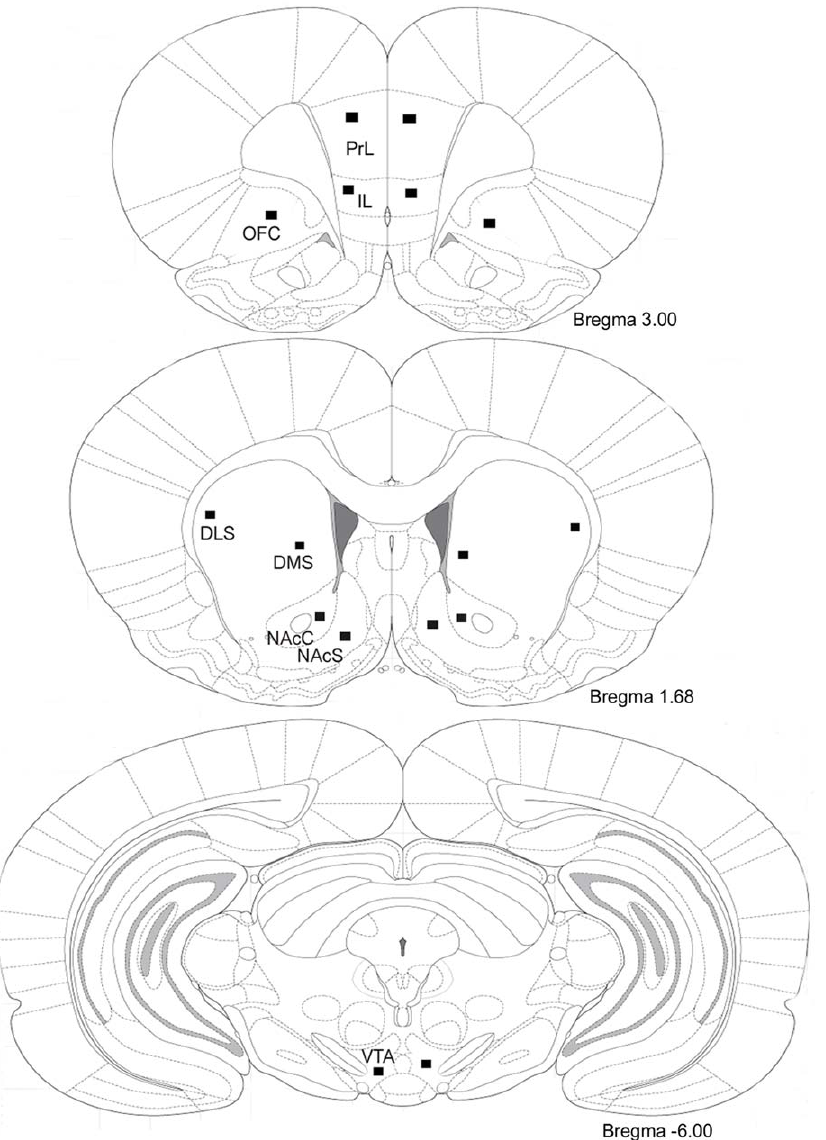
Figure 5. Schematic diagrams of coronal sections of rat brain. The locations that FosB/ D FosB immunoreactivity was quantified in the following regions: prelimbic cortex (PrL), infralimbic cortex (IL), orbitofrontal cortex (OFC), nucleus accumbens core (NAcC), nucleus accumbens shell (NAcS), dorsolateral striatum (DLS), dorsomedial striatum (DMS), and the ventral tegmental area (VTA). The black squares correspond to a fixed area 200 m m 6 200 m m in